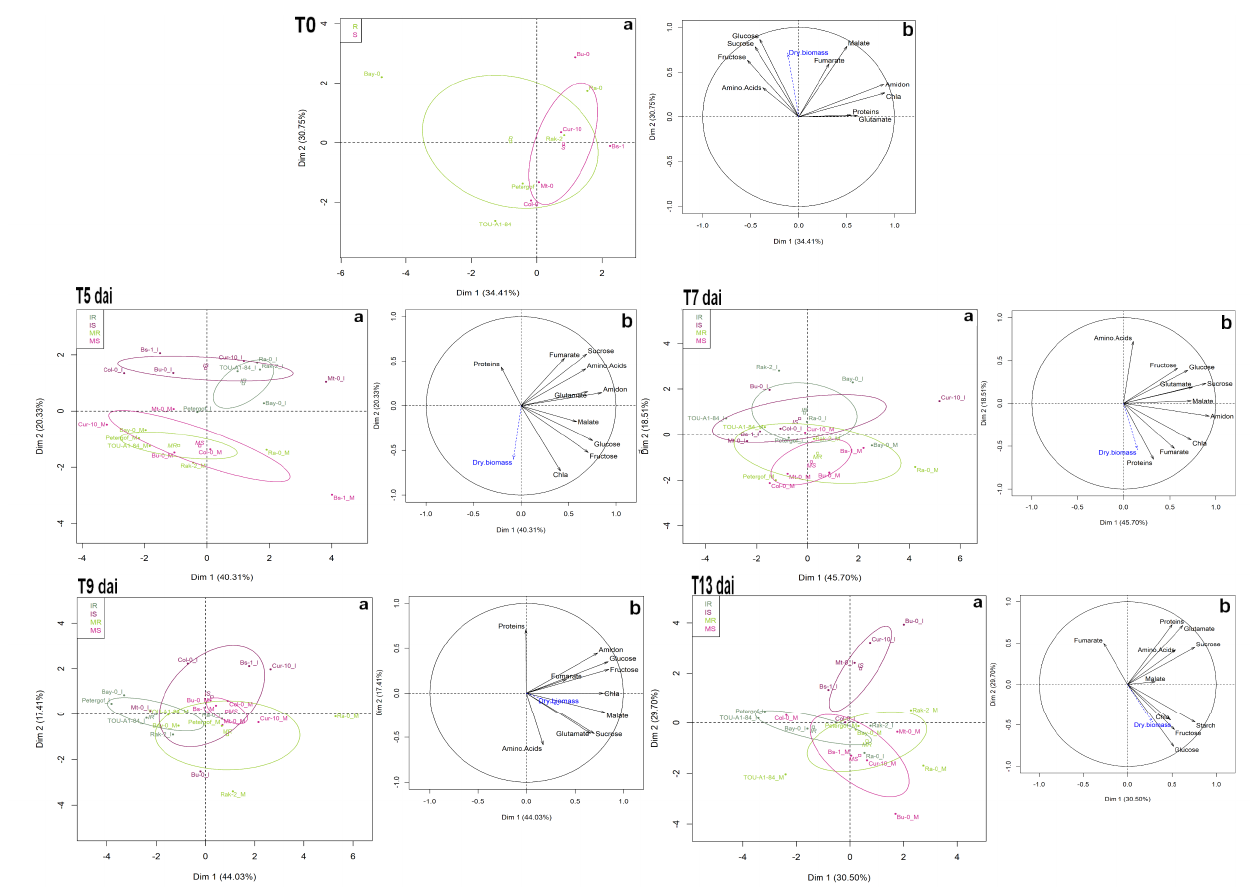
Figure 4. Principal component analysis (PCA) performed with 10 primary metabolic traits measured at 0 (T0), 5 (T5), 7 (T7), 9 (T9) and 13 (T13) days after inoculation on 10 A. thaliana accessions mock and TuMV inoculated in the ‘2017’ field experiment. a Score plot of individuals. Score plots of resistant accessions are in green, light green for mock-inoculated, dark green for TuMV-inoculated. Score plots of susceptible accessions are in pink, light pink for mock-inoculated, dark pink for TuMV-inoculated. The confidence ellipses around the centroid of individuals are represented. b Variable correlation graph. Dry biomass was considered as explanatory traits (in blue on the variable factor map). Chla = Chlorophyll a.